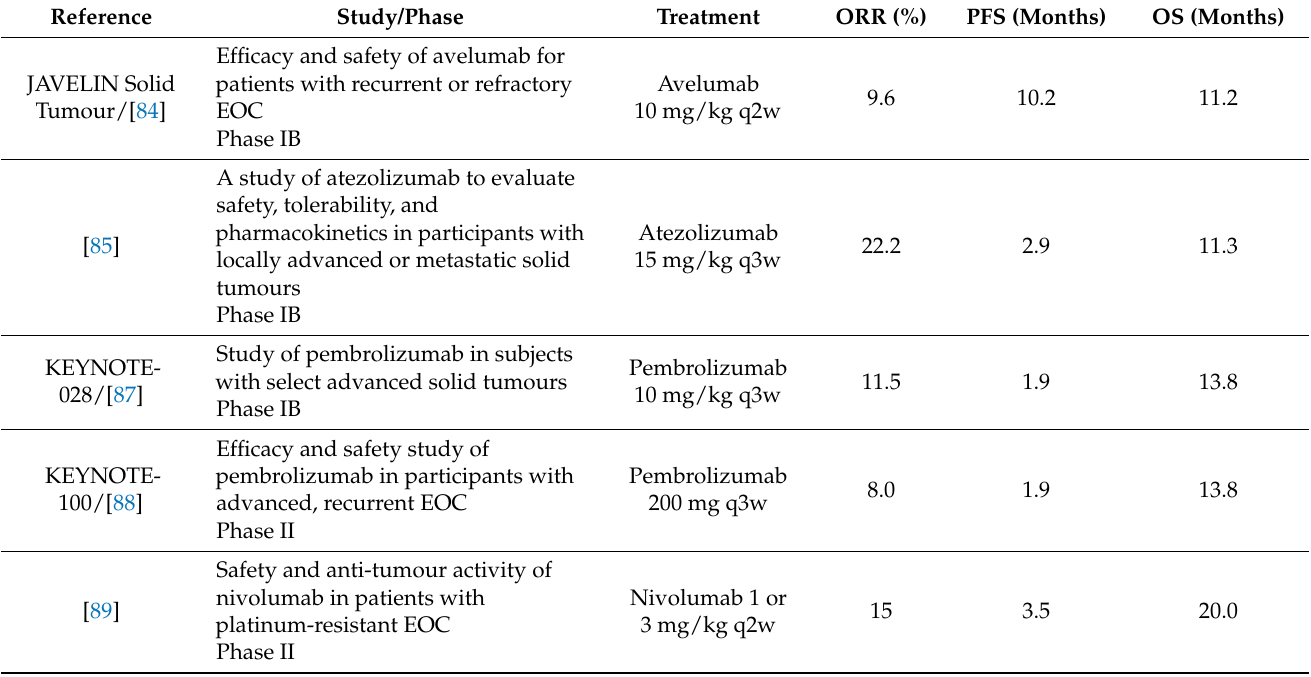
Table 2. Results from trials exploring efficacy and safety of single-agent ICI in